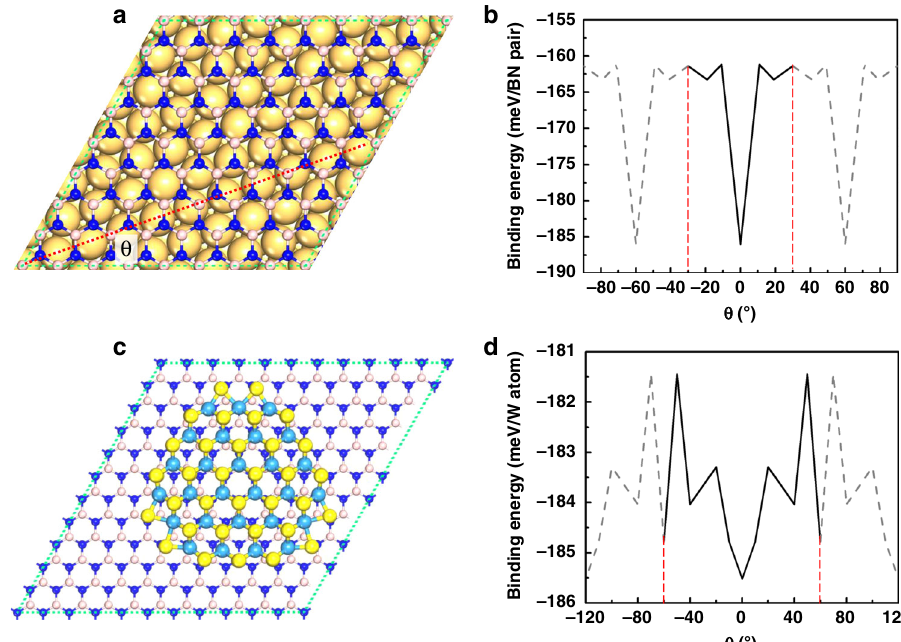
Fig. 3 The calculated interactions between the bulks of 2D materials and substrates. Periodic boundary condition model of hBN on the Cu(111) surface a and the calculated binding energies of hBN on the Cu(111) surface as a function of the alignment angle ( θ ) between the ZZ direction of hBN lattice and a 〈 110 〉 direction of the Cu(111) surface b . Cluster model of a WS 2 cluster on the hBN surface c and the calculated binding energies of the WS 2 cluster on the hBN surface as a function of the alignment angle ( θ ) between the ZZ direction of WS 2 and the ZZ direction of the hBN surface d